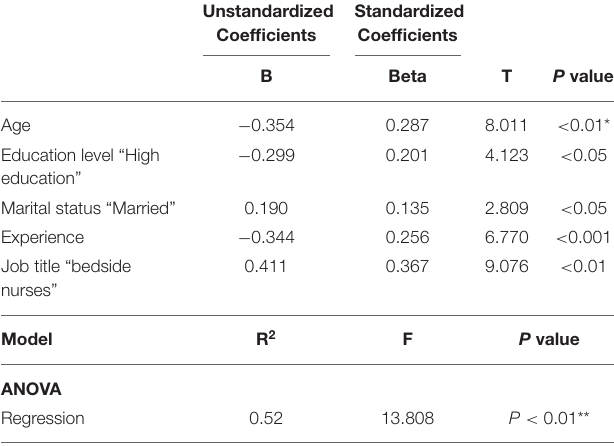
TABLE 8 | Multiple linear regression (MLR) models for anxiety scale.